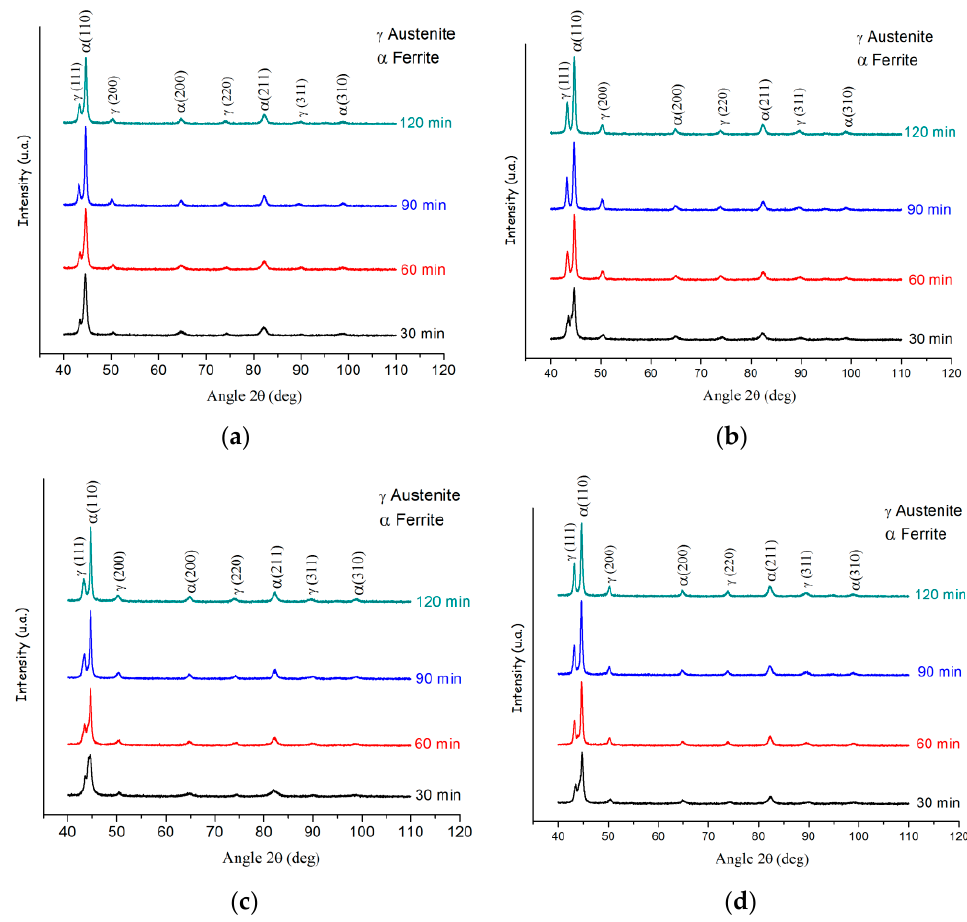
Figure 10. X-ray diffraction patterns of samples ( a ) CADI-0.2Cr-265, ( b ) CADI-0.2Cr-305, ( c ) CADI- 0.4Cr-265, and ( d ) CADI-0.4Cr-305.